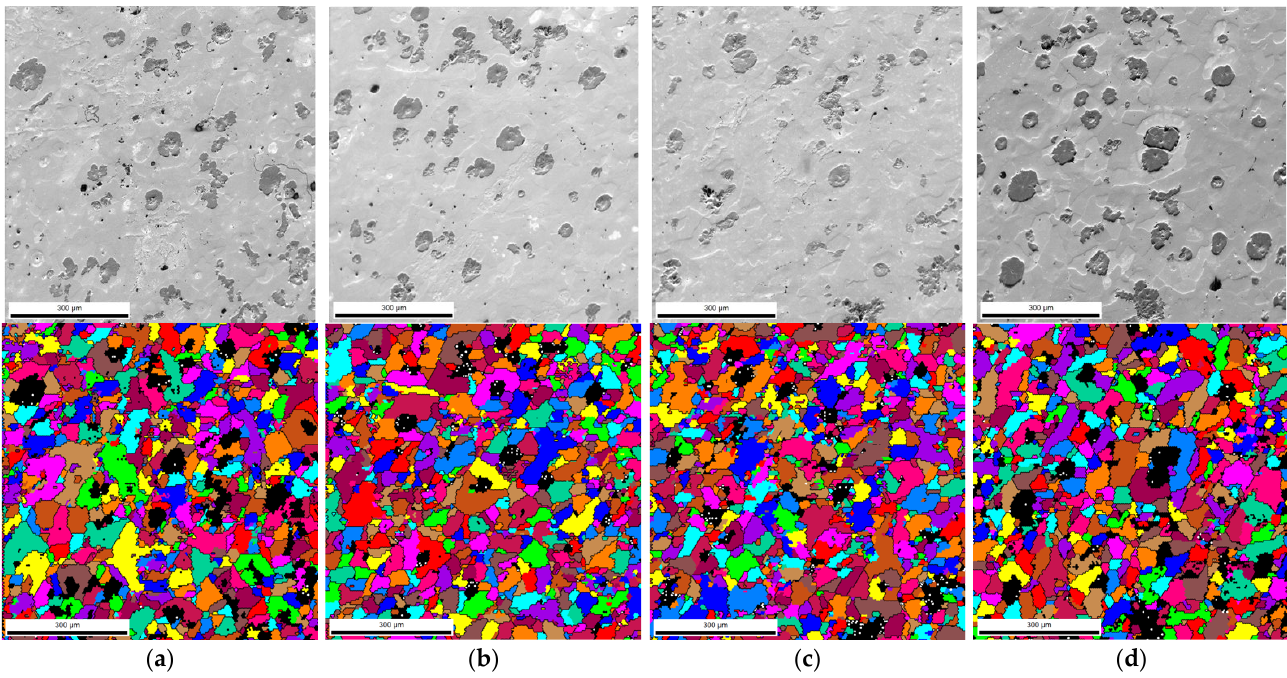
Figure 9. SEM images and unique grain color maps of ( a ) noP Un , ( b ) CP Un , ( c ) LCP Un , and ( d ) TP Un .